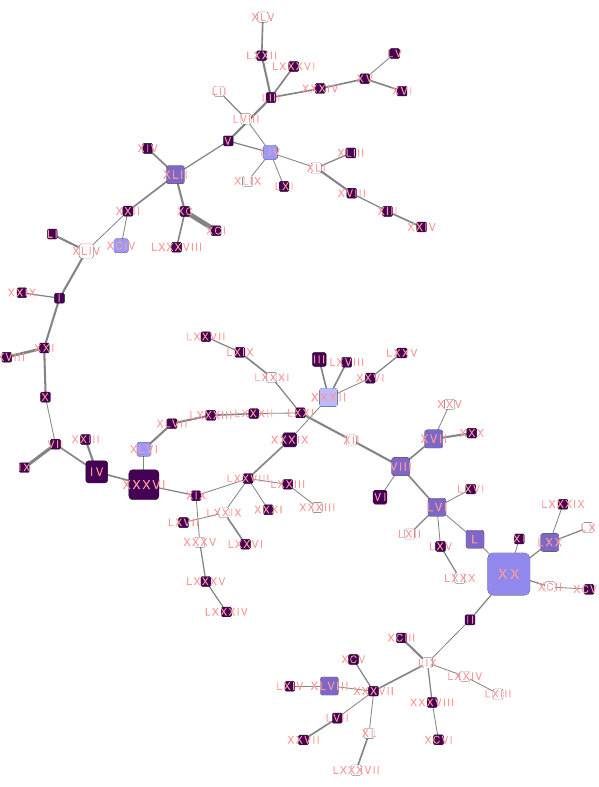
Figure 5. Haplotype network for all Omicron SARS-CoV-2 sequences from Mexico City. The size of each node is proportional to the number of samples that belong to that haplotype. The color represents the fraction of patient samples that were fully vaccinated for each haplotype. The white nodes belong to haplotypes with 100% nonvaccinated patients, and dark purple nodes belong to haplotypes with 100% fully vaccinated patients. The width of the lines is proportional to the number of mutations between two haplotypes.